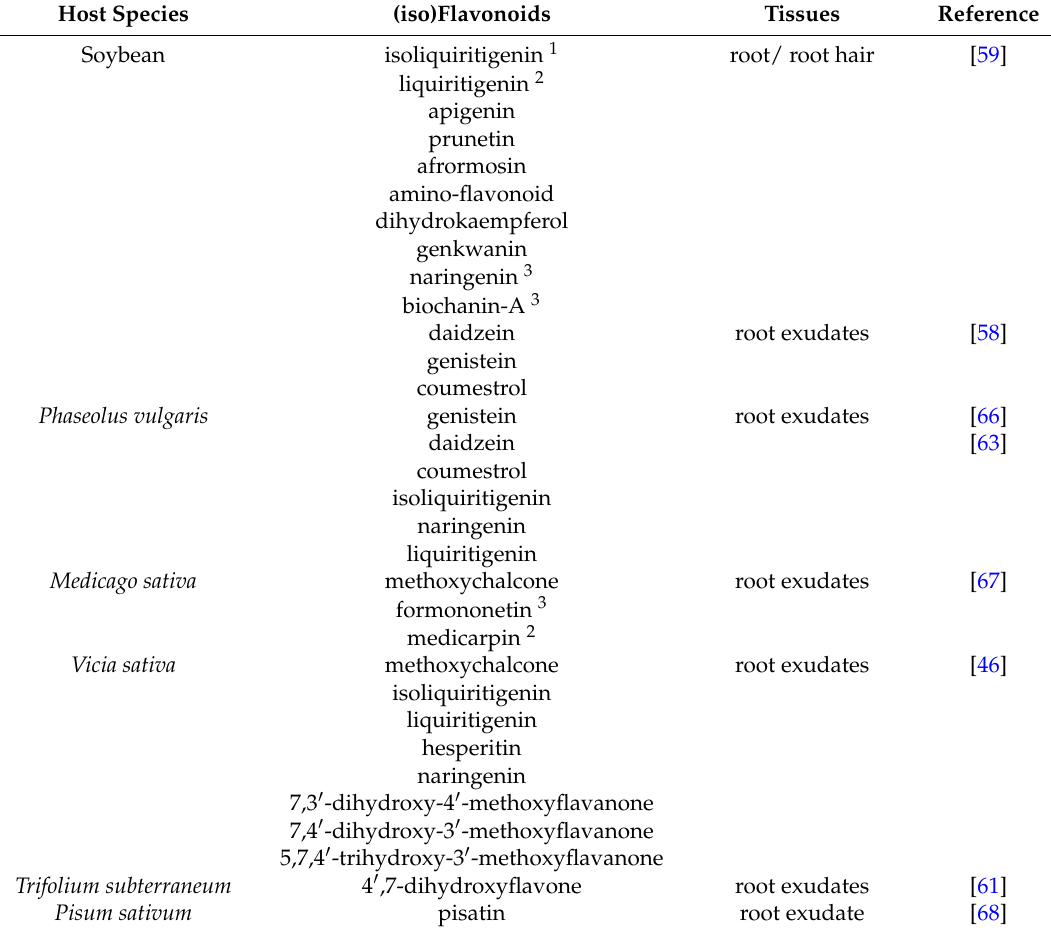
Table 1. Rhizobia and Nod factor-induced